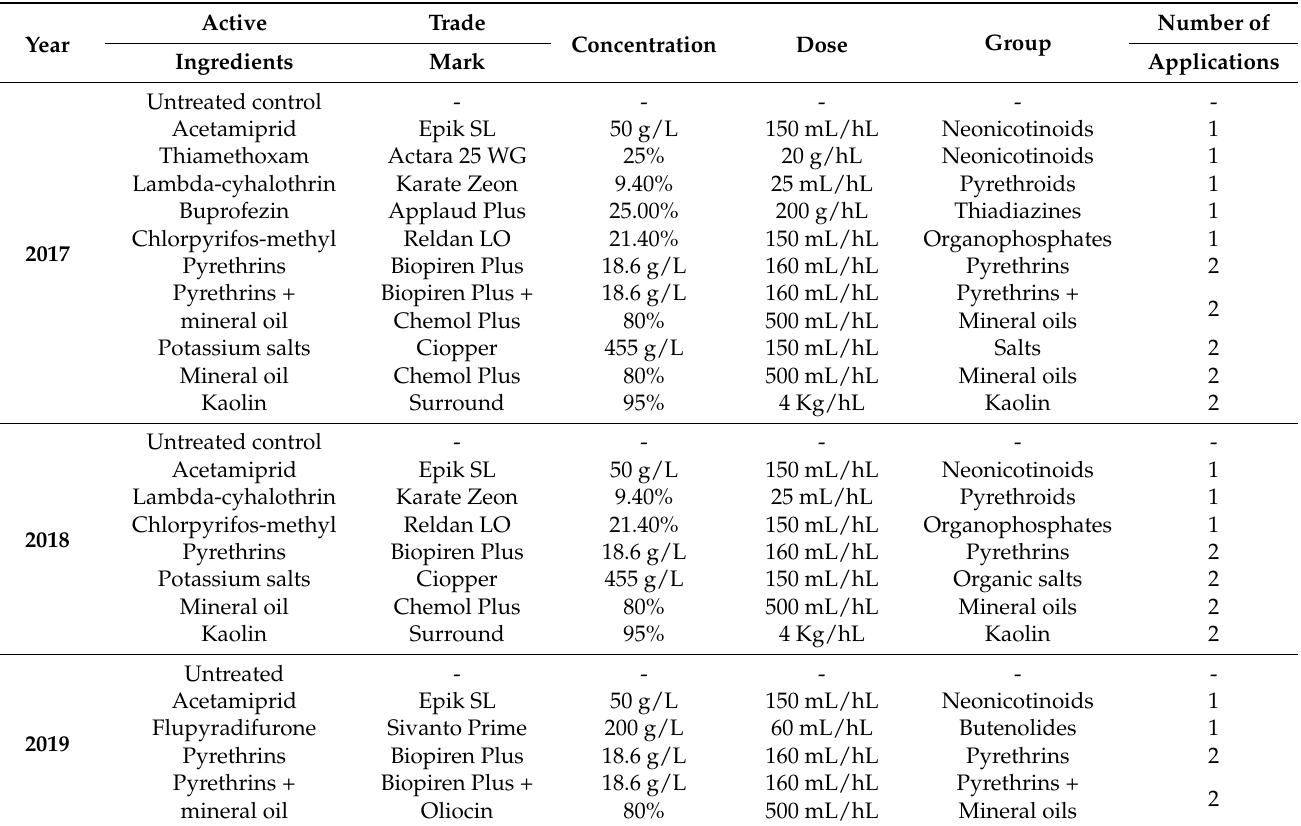
Table 1. Insecticides selected for field